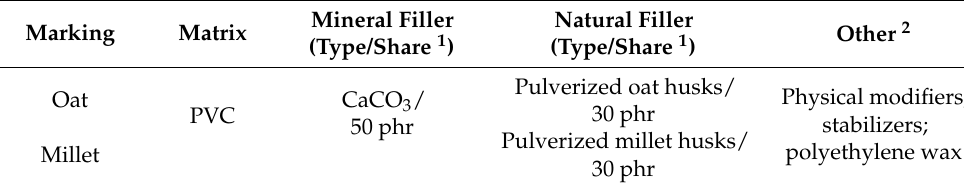
Natural Filler (Type/Share 1 ) Pulverized oat husks/ 30 phr